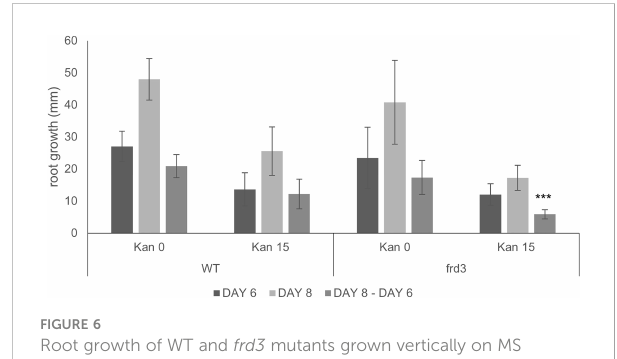
FIGURE 6 Root growth of WT and frd3 mutants grown vertically on MS medium with and without Kan 15 mg/l. Root growth was recorded at days 6 and 8 and growth difference between the two dates was calculated. *** denotes P<0.001 when compared to root growth difference for WT on Kan 15 (Student t